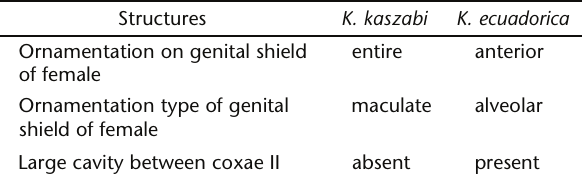
Table I. The most important differences between Kaszabjbaloghia kaszabi and K. ecuadorica .